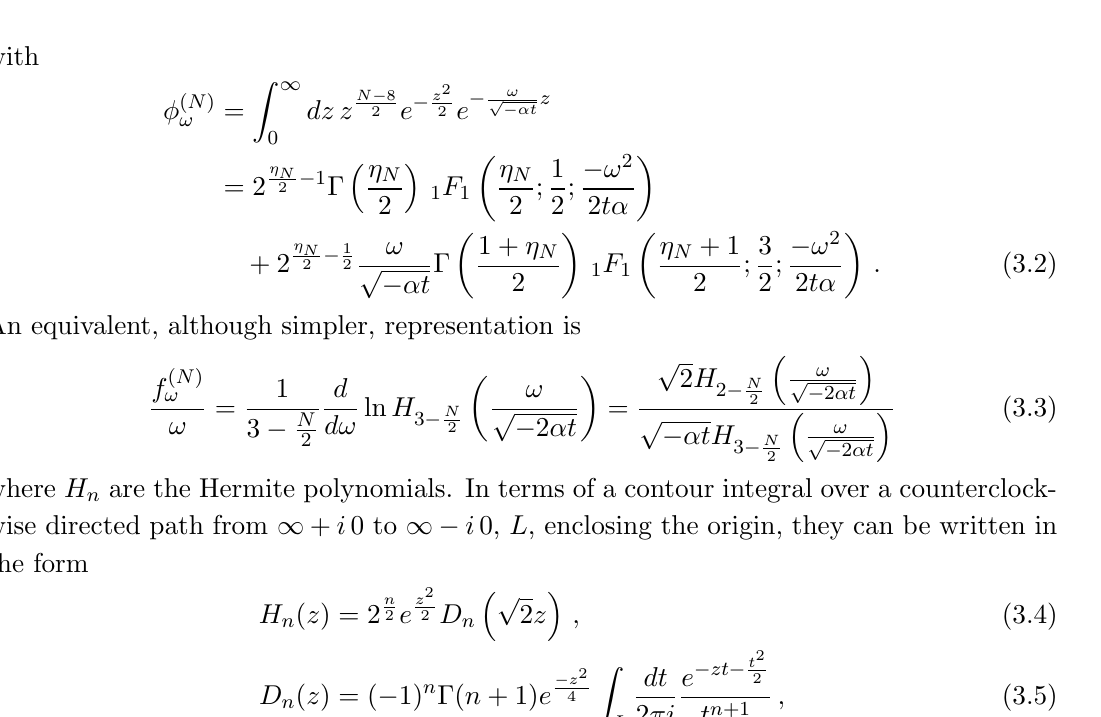
Figure 1 . The DL exact amplitudes for di(cid:11)erent supergravities with N = 5 ; 6 ; 7 ; 8 as a function of s with (cid:20) 2 = 8 (cid:25) 2 and t = (cid:0)